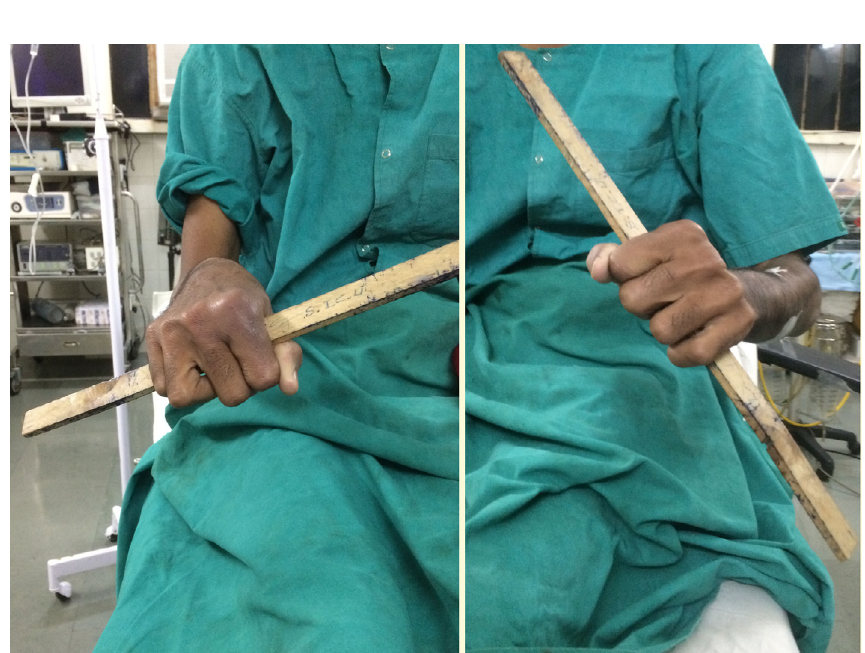
Figure 2. Preoperative photograph showing the elbow fixed in pronation of 70 (cid:2) on right side and 40 (cid:2) on left side.